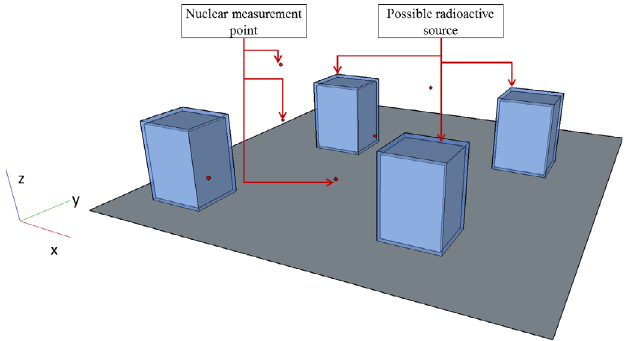
Fig. 13. Radioactive sources scene modelling.